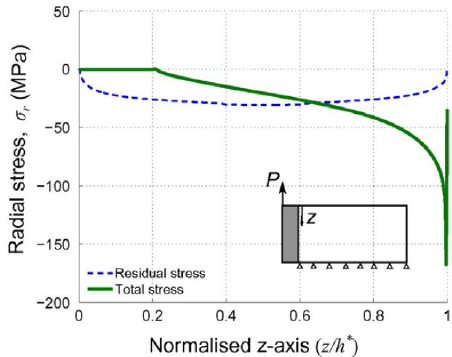
Figure 16. Normal (radial) stress distribution along the z-Pin / laminate interface (CFRP z-Pins, d = 0.51 mm, [0] pre-preg, t = 4 mm) [21].